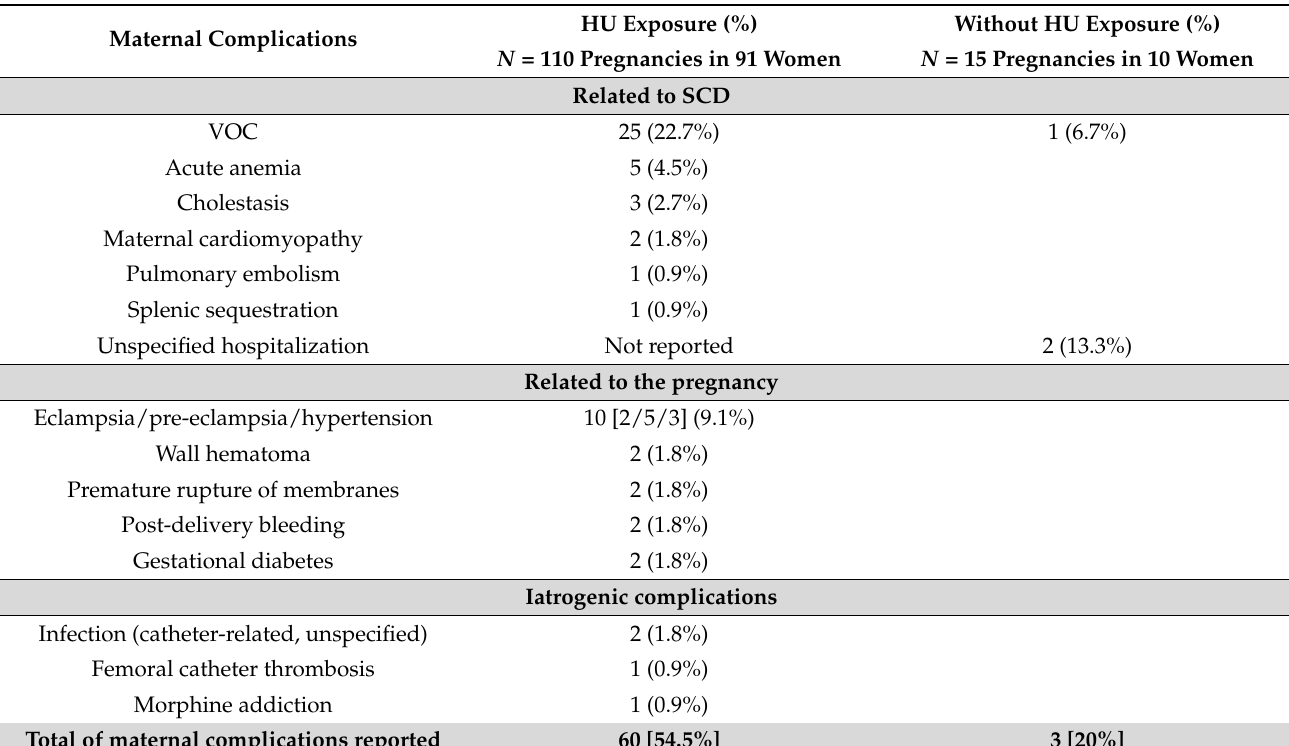
Table 5. Maternal complications in ESCORT-HU SCD women following HU exposure or